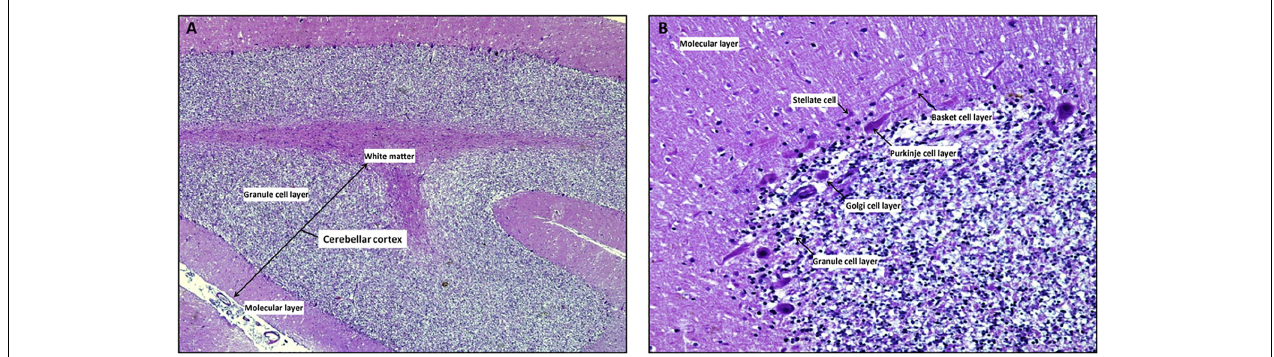
FIGURE 2 | The cerebellar cortex. Mid-sagittal section reveals the three layers in cerebellar folia: the superficial molecular layer, the deepest called granular and the Purkinje cells layer at the interface between the granular and molecular layers Note the inner white core of white matter ( A , x4 hematoxylin/eosin stain). At higher magnification, the molecular layer contains superficially located stellate cells, basket cells which are scattered among dendritic ramifications and numerous thin axons that run parallel to the long axis of the folia. Ganglionic or Purkinje cell layer is formed of a single row of Purkinje cells with large pear-shaped bodies; while the granular layer is composed by small granule cells with dark-staining nuclei/scanty cytoplasm and Golgi type II cells ( B , x20 hematoxylin/eosin stain).